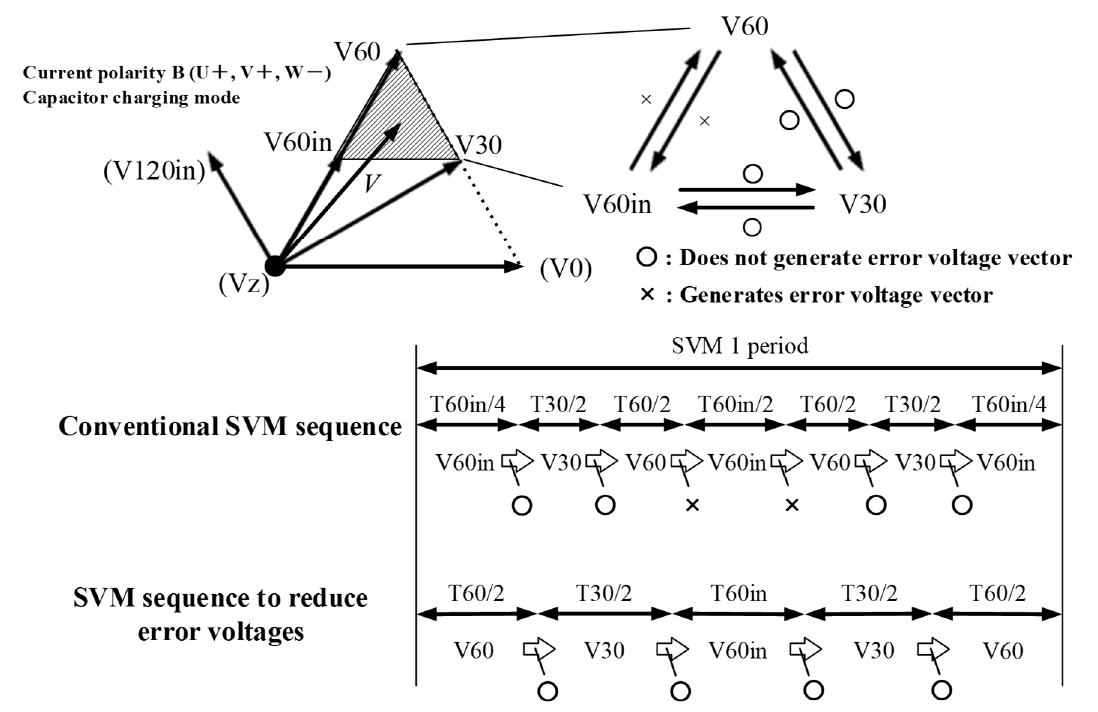
Figure 11. SVM sequence to reduce error voltage vector during dead time.